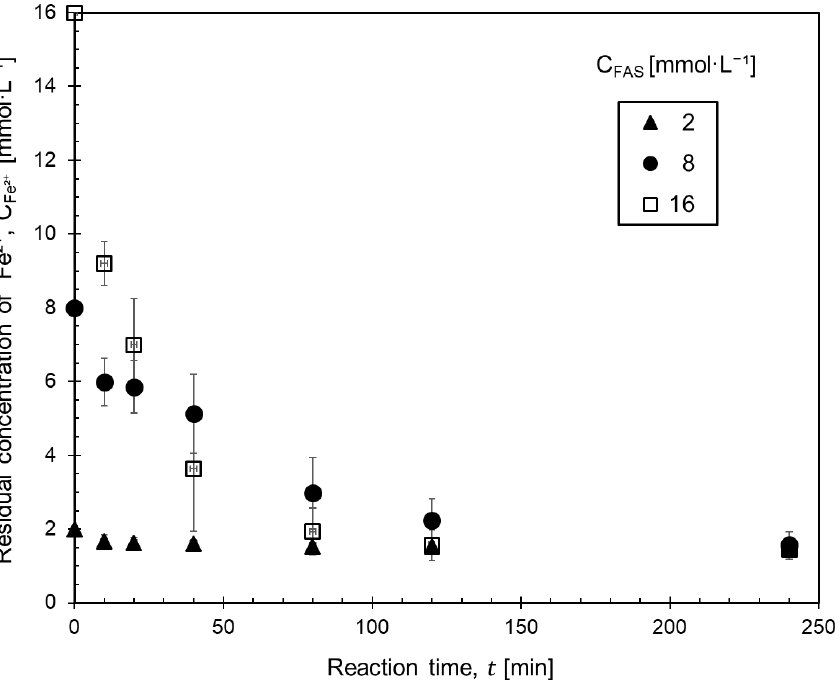
Figure 6. Effect of the concentration of ferrous ammonium sulfate ( 𝐶 𝐹𝐴𝑆 ) on the precipitation behav- ior of ferrous oxalate at 𝐶 𝑂𝐴 = 60 mmol·L − 1 and 25 °C. of ferrous oxalate at C · L − 1 and 25 ◦ OA = 60 mmol